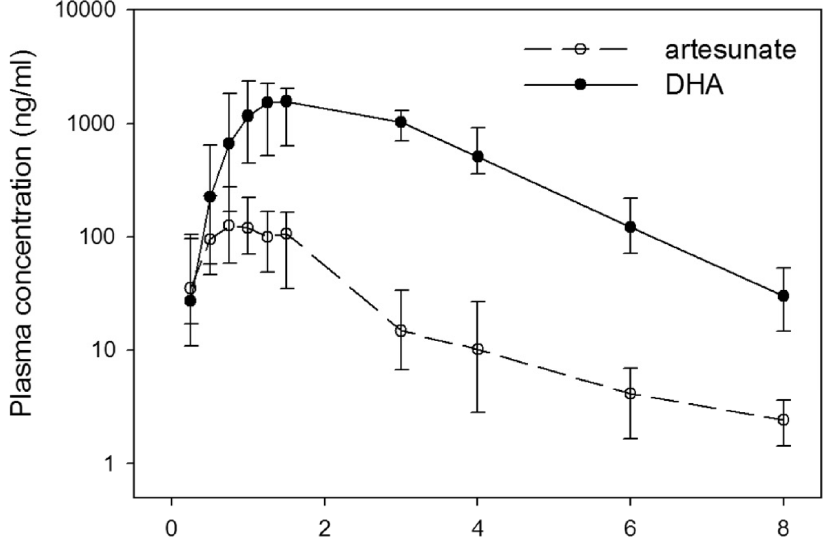
Figure 7. Plasma concentration-time curve of artesunate (dashed line) and DHA (solid line).